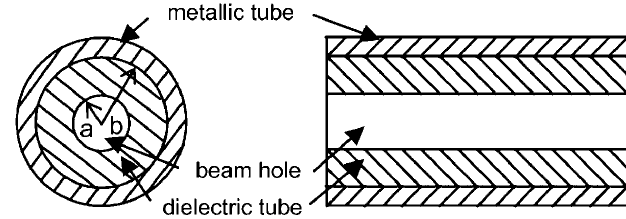
FIG. 1. Transverse and longitudinal cross-sectional views of the circular dielectric-loaded